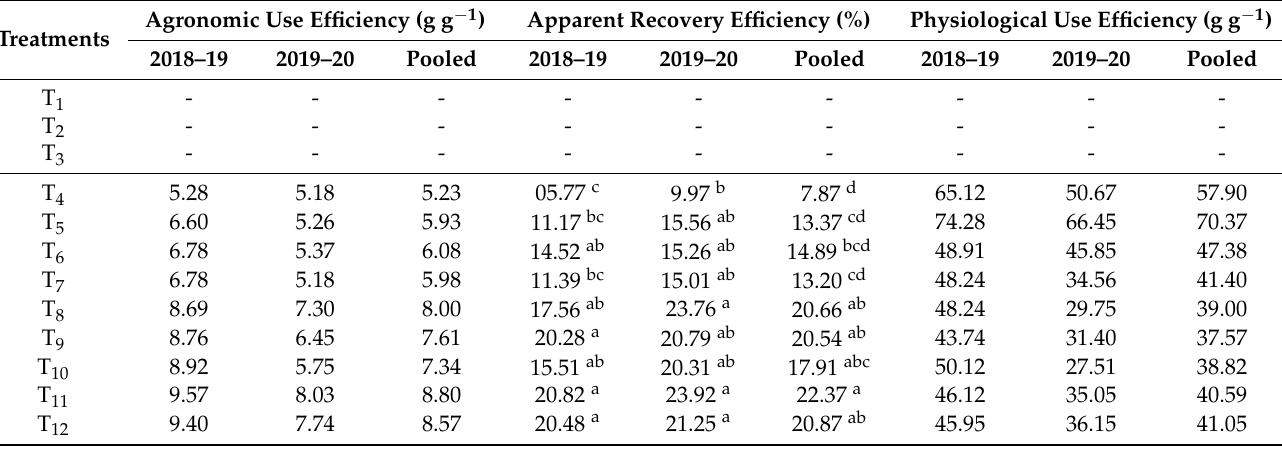
Table 4. Sulphur use efficiency as influenced by the seed biopriming and varied levels of S fertilization in